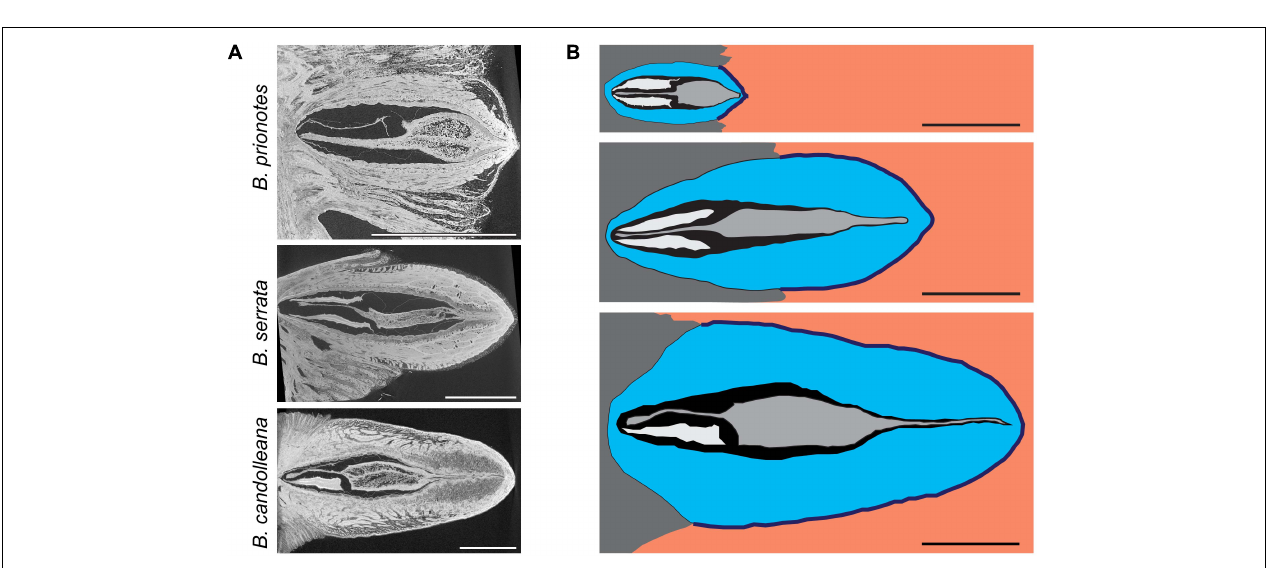
FIGURE 4 | Structural and geometrical analysis of follicles. (A) Micro-CT images of follicles in the longitudinal view: B. prionotes follicles show a porous exocarp in contrast to the other two species (this follicle aborted both seeds). A highly porous separator can be identified in all three species. (B) Schematic drawing based on longitudinal sections of follicles from all three species (top to bottom: B. prionotes, B. serrata, B. candolleana ) showing the differences in size, geometry and embedment of all follicles and their components (valves in blue, seed separator in grey, seeds in white/ wings not displayed, embedment in dark grey). Orange area indicates areas with direct exposure to flames. Sometimes only one (as seen in B. candolleana here) or no seed is developed. All scale bars: 1 cm.